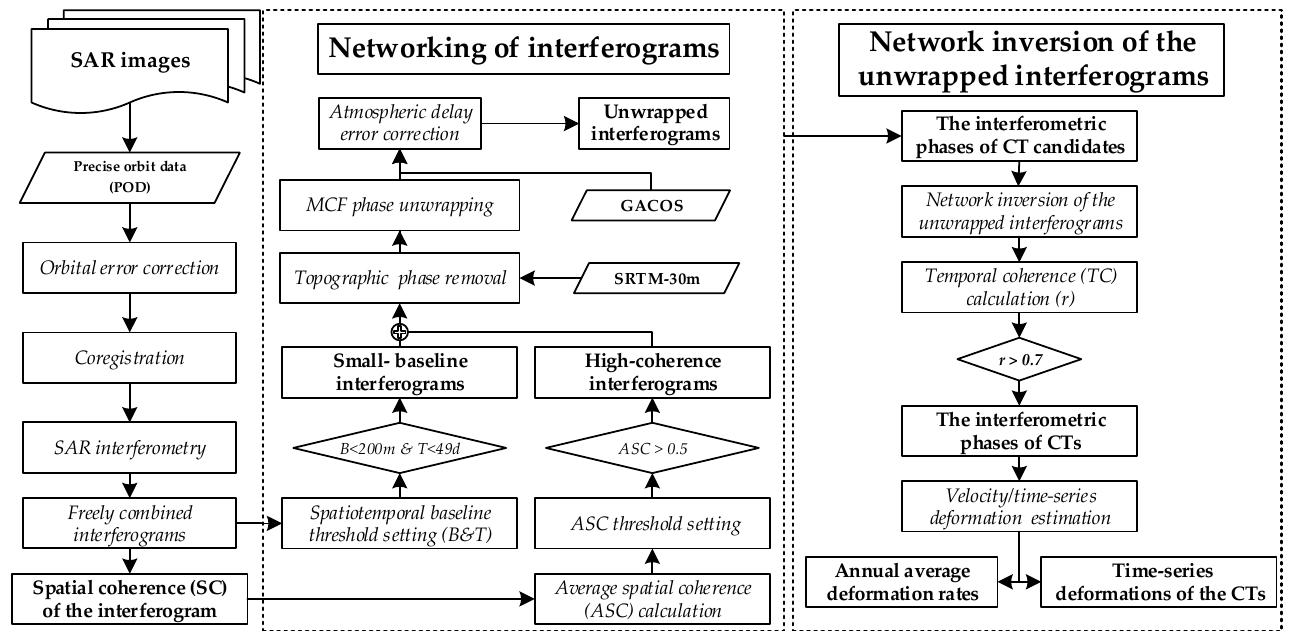
Figure 1. The processing flow of the improved TS-InSAR, B and T indicate perpendicular baseline and temporal baseline, respectively.